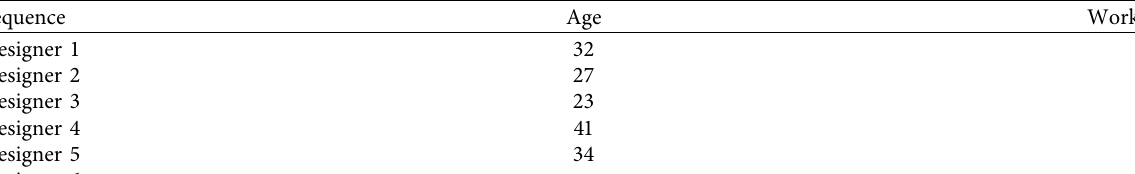
Table 4: Designer personal information.